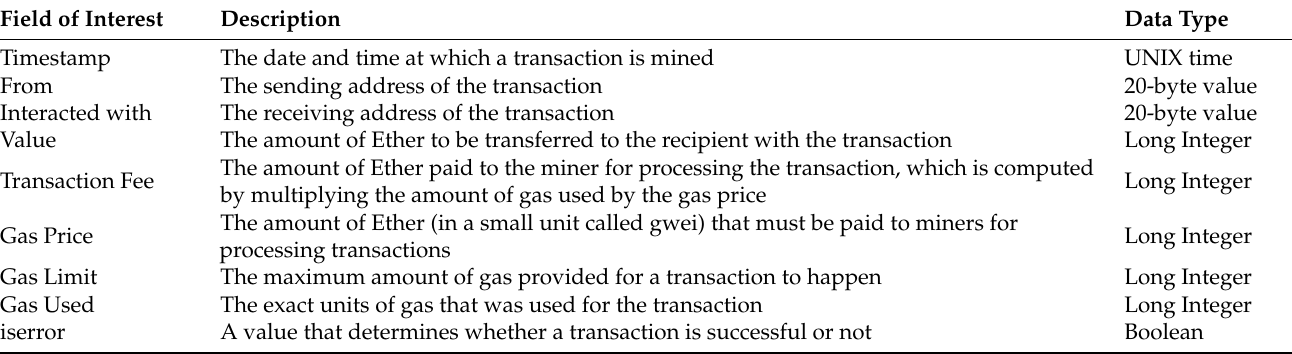
Table 3. Transaction fields of interest.